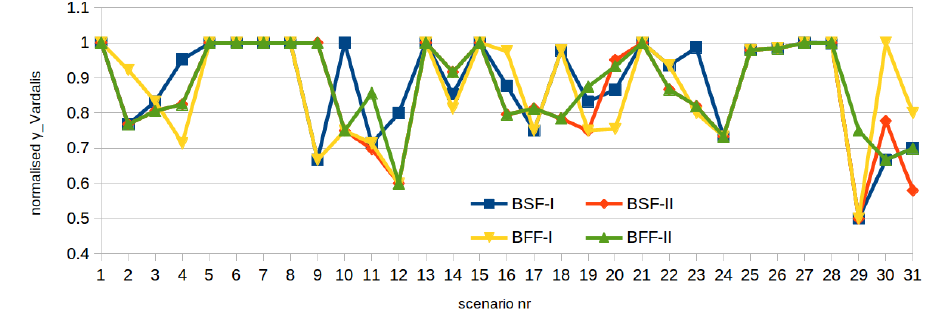
Figure 23. Vardalis’s fairness index, normalized by NFF, for different fair allocation methods, based on the numerical results in Tables 10–14.